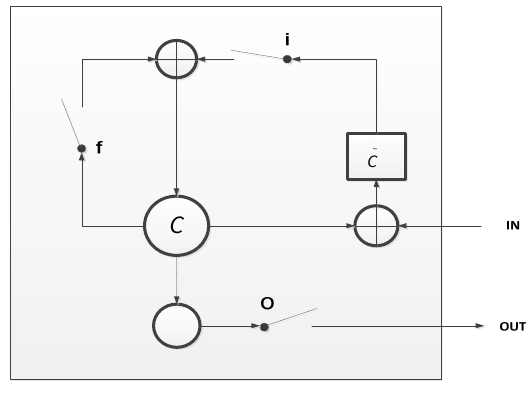
Figure 2. Long–short term memory (LSTM) node.